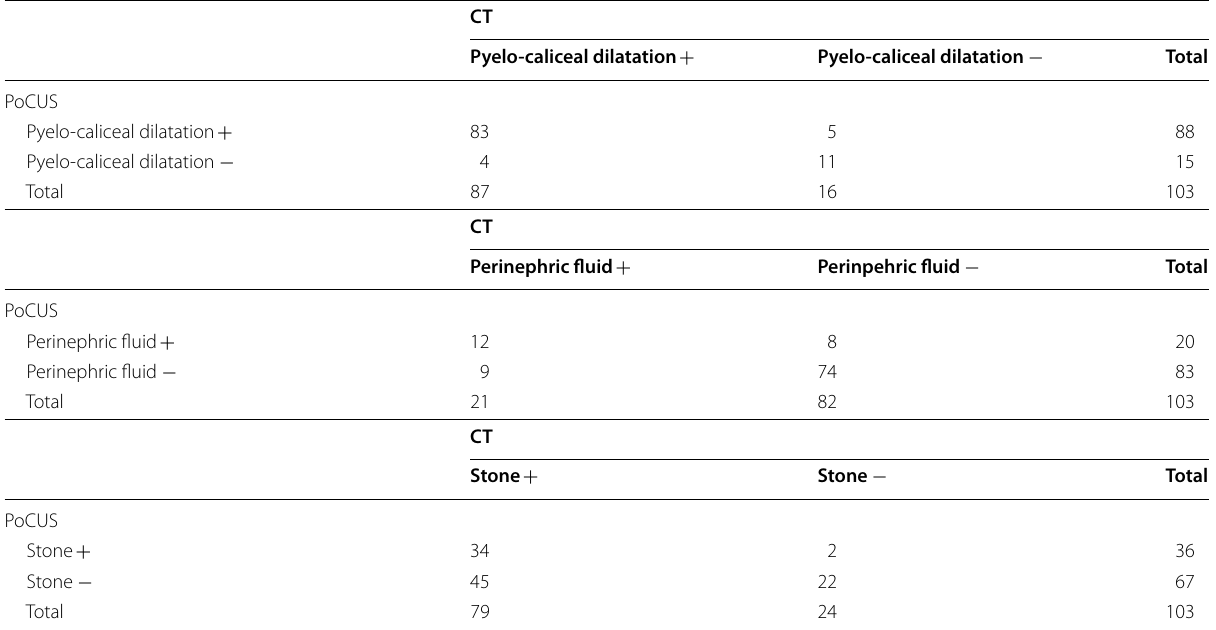
Table 2 PoCUS findings compared to CT